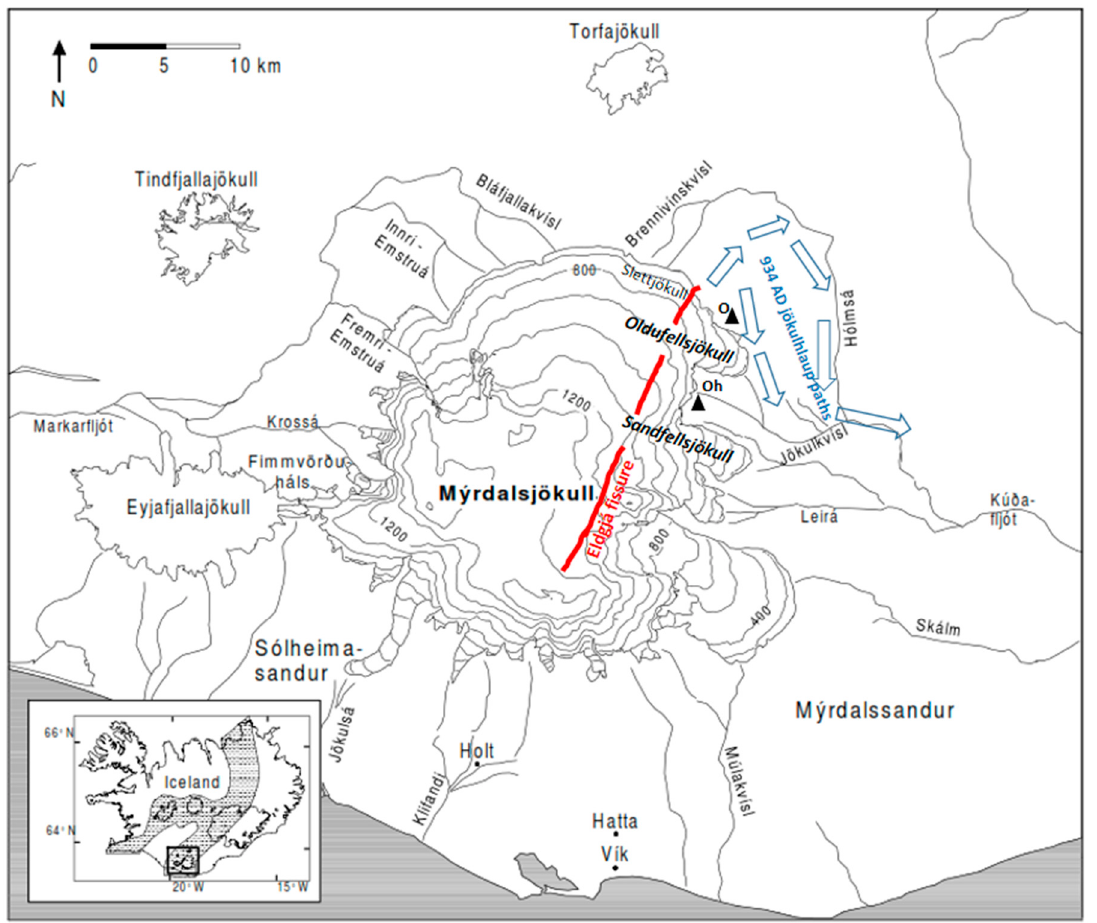
Figure 1. Location map showing the Mýrdalsjökull ice cap and its outlet lobes and key volcanic features and the jökulhlaup flood paths that have impacted on the Sandfellsjökull and Oldufellsjökull forelands. Inset map shows the extent of the central volcanic zone (stippled pattern).